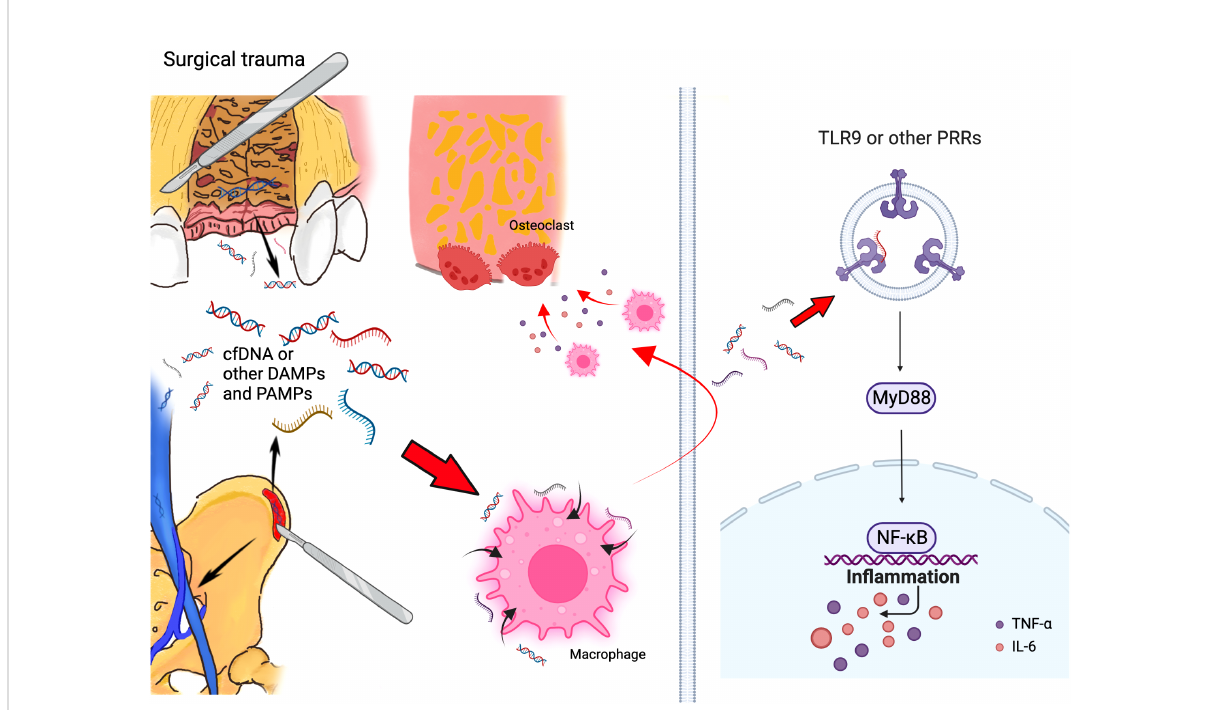
FIGURE 2 Schematic of mechanism that cfDNA and other DAMPs and PAMPs can promote bone loss initiated by surgical trauma during alveolar bone grafting. Surgery can accumulated cfDNA and other DAMPs and PAMPs, and these molecules can consistently activate the TLR9 and other PRR pathways, which activate the innate immune response and lead to bone loss after alveolar bone grafting. (Created with